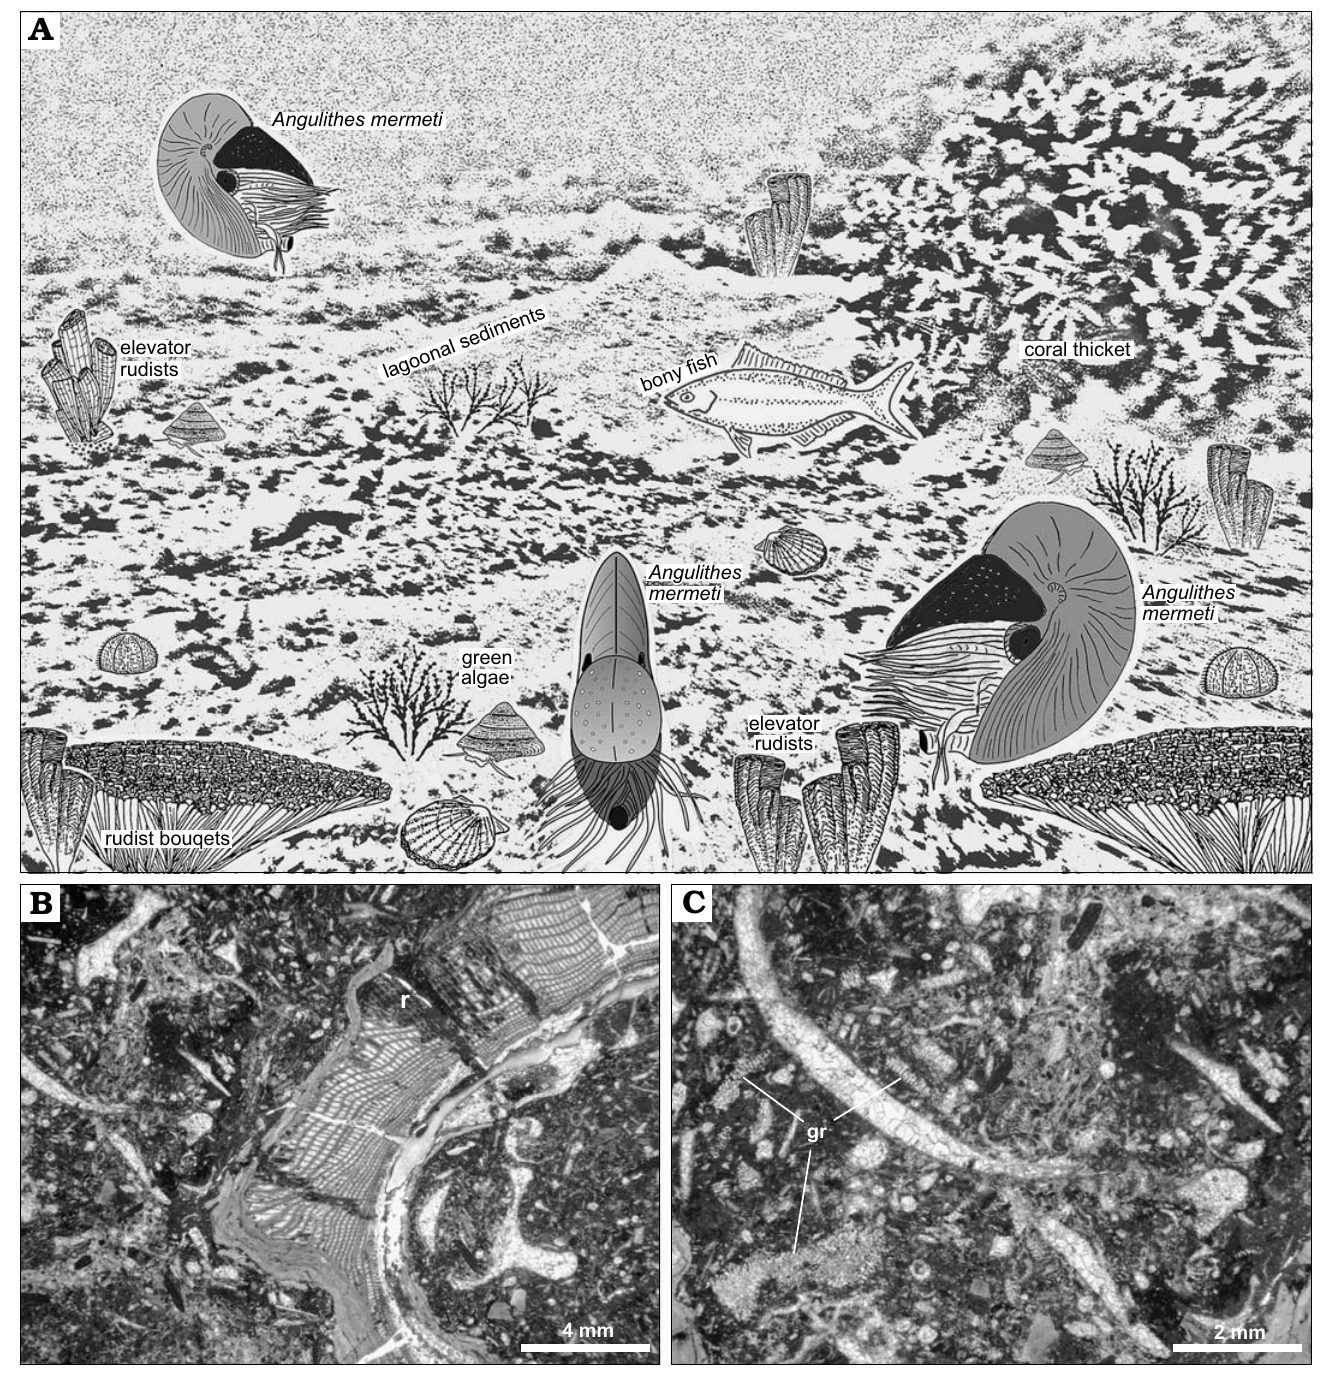
Fig. 10. Palaeoecology of the hercoglossid nautiloid Angulithes mermeti (Coquand, 1862). A . Reconstruction of A. mermeti (Coquand, 1862) in the la- goonal shallow-water environment of the Galala Formation (background after a subaqueous photograph in the property of MW from a lagoonal site in the present-day Red Sea near Hughhada taken in 1999, treated by greyscale-filtering in Photoshop CS2); rudist illustrations from Mitchell (2002). B . Bioclastic rudist (r) floatstone, the lagoonal host sediment in which A. mermeti has been found in the Wadi Ghonima section (thin-section photomicrograph of sample 080217-18). C . Close-up of Fig. 9B showing the bioclastic packstone matrix in detail, including numerous fragments of dasycladalean algae